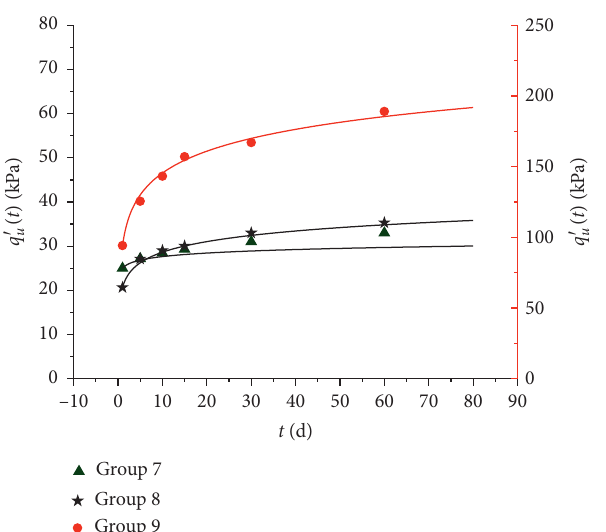
Figure 8: Comparison of the data of the literature [24] and model